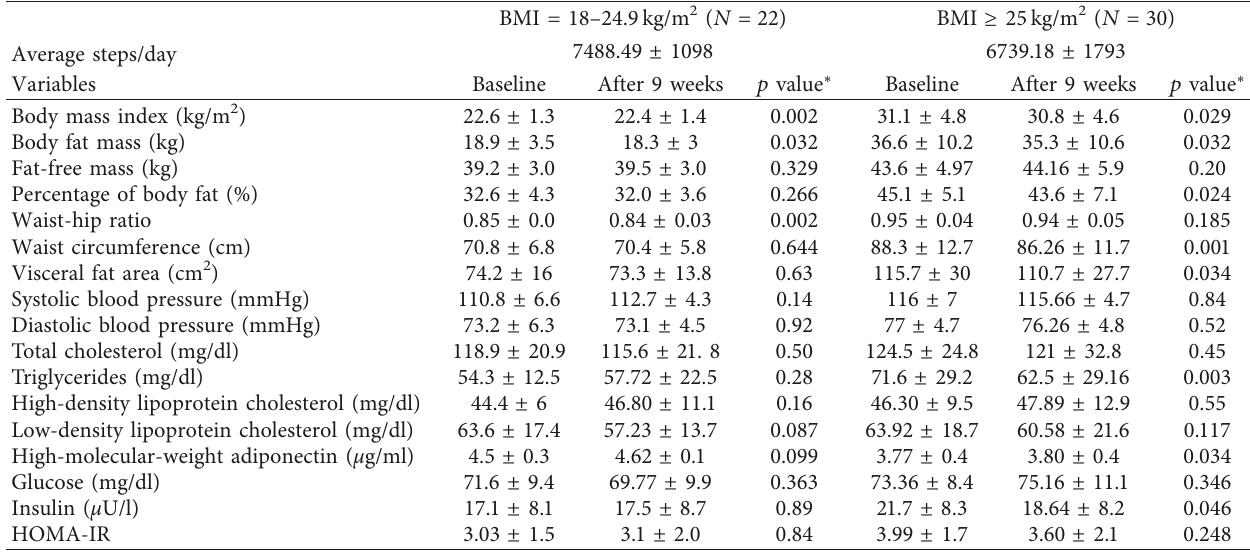
Table 3: Comparisons of the means of obesity measures, blood pressure, and biochemical parameters in participants with normal and high BMIs before and after intervention ( N �